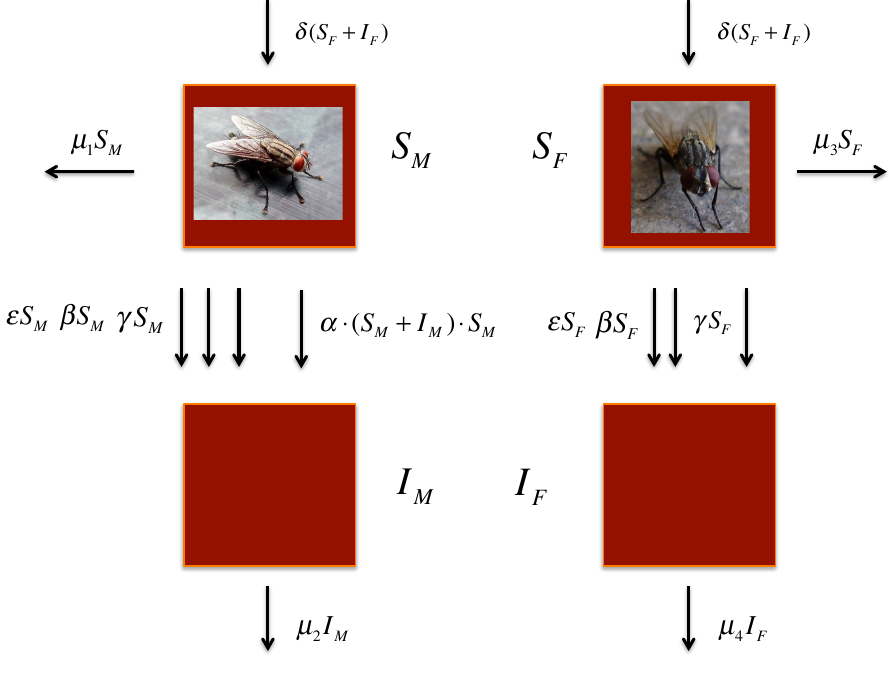
Figure 1. Diagram of transmission pathways of MdSGHV between infected ( I ) and susceptible ( S ) flies, where ε is the rate of oral infection, α is the rate of male interaction, β is the rate of transmission for feeding, γ is the rate of transmission for environmental contamination, and µ is the death rate for susceptible males (1), infected males (2), susceptible females (3), and infected females (4). There are no arrows from infected to susceptible because there are no instances of recovery. Images retrieved from: (http://commons.wikimedia.org/w/index.php?search=house+fly&title= Spe- cial%3ASearch).